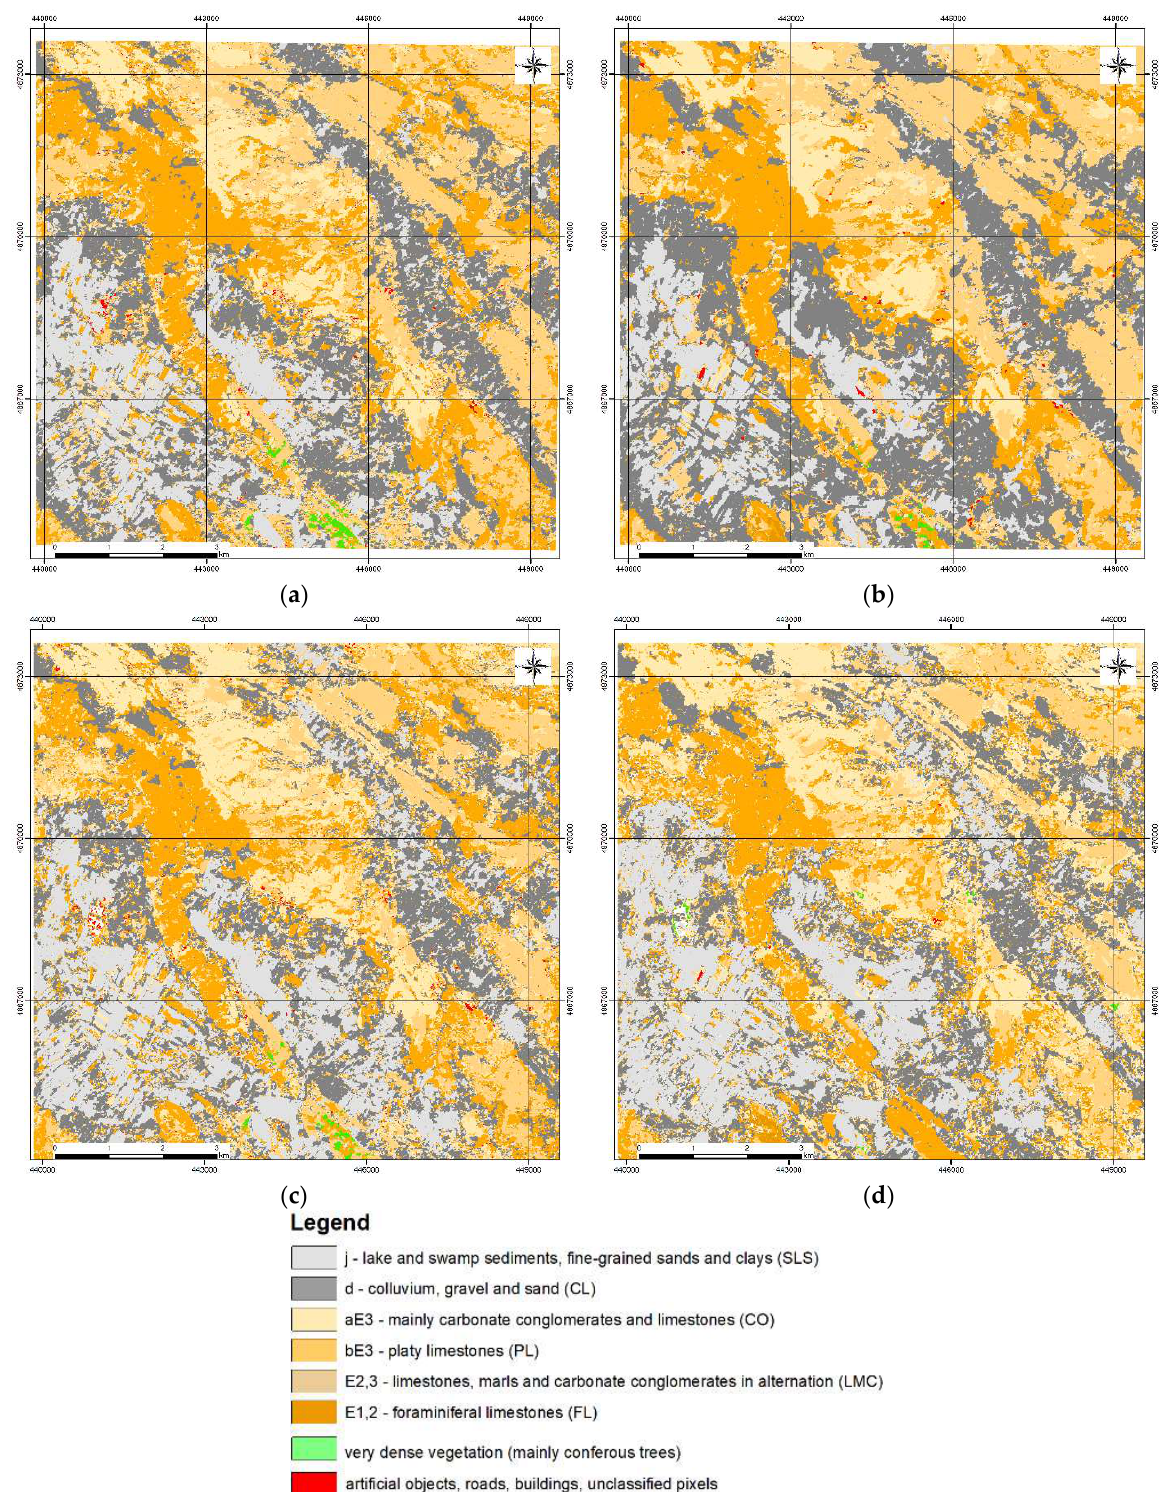
Figure 11. RF classification results; ( a ) RF variant 1 and bands 2, 3, 4, 8 and 11; ( b ) RF variant 1 and all bands; ( c ) RF variant 2 and Bands 2, 3, 4, 8 and 11; ( d ) RF variant 2 and all bands. In the DFA of the investigated lithological units, six groups (K = 6) and twelve varia- bles (descriptors, p = 12) were processed, resulting in a DFM of five discriminant functions (K – 1). Relevant multivariate tests were used before the analysis (Table 2), revealing ex-